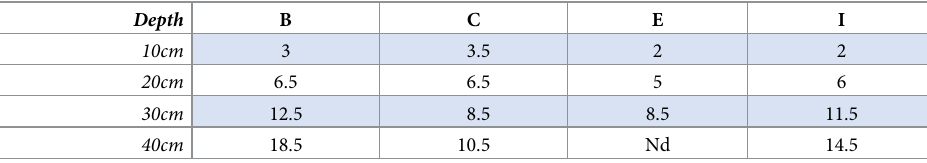
Table 4. Lag time (in h) between surface water and hyporheos maximum temperature at different depths.